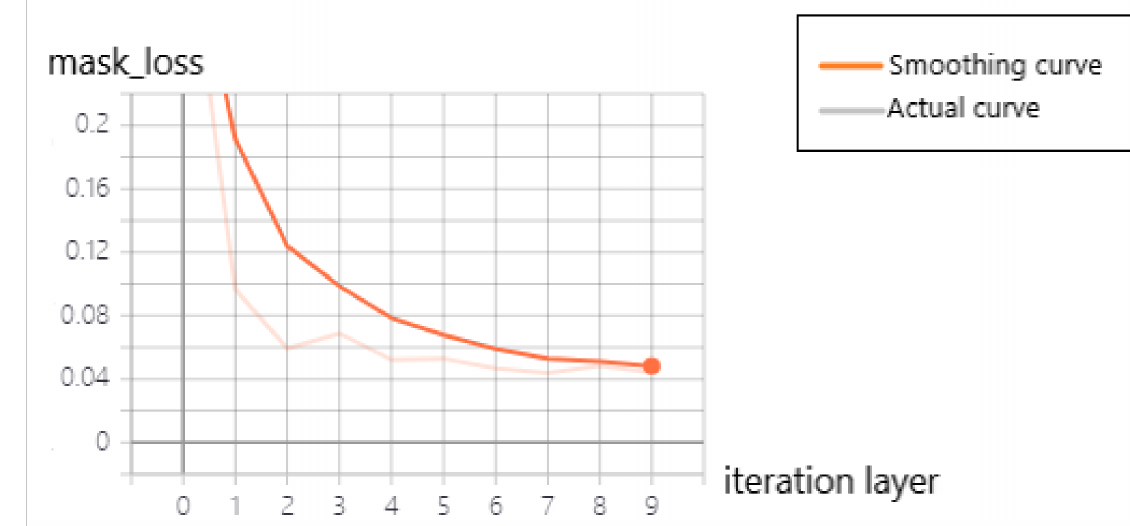
Figure 22. Mask loss of Mask R-CNN 1.